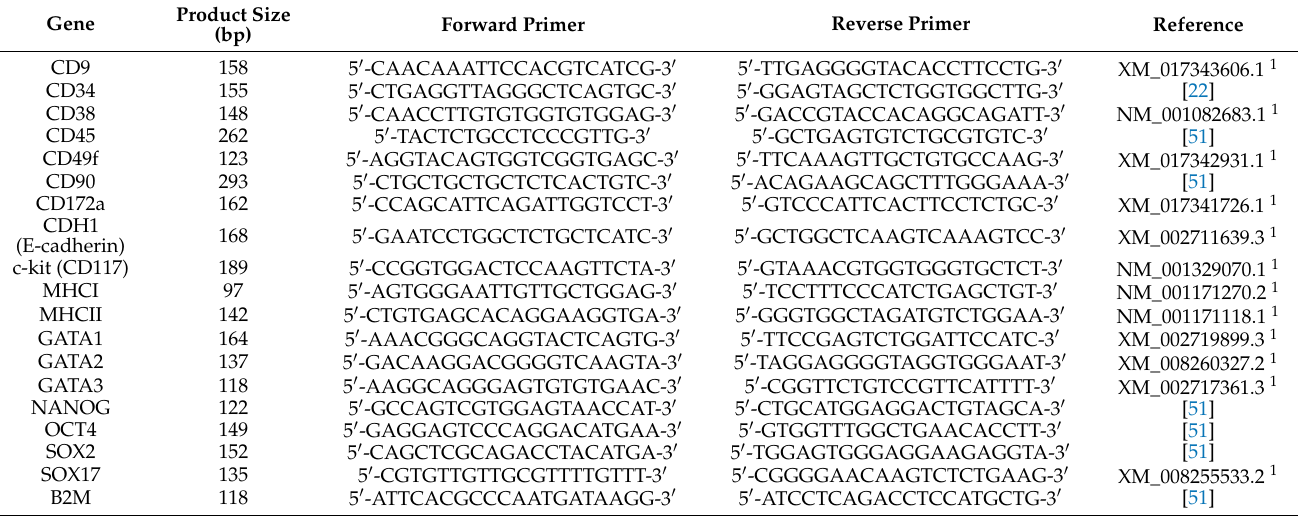
Table 2. Gene-specific primers and size of PCR